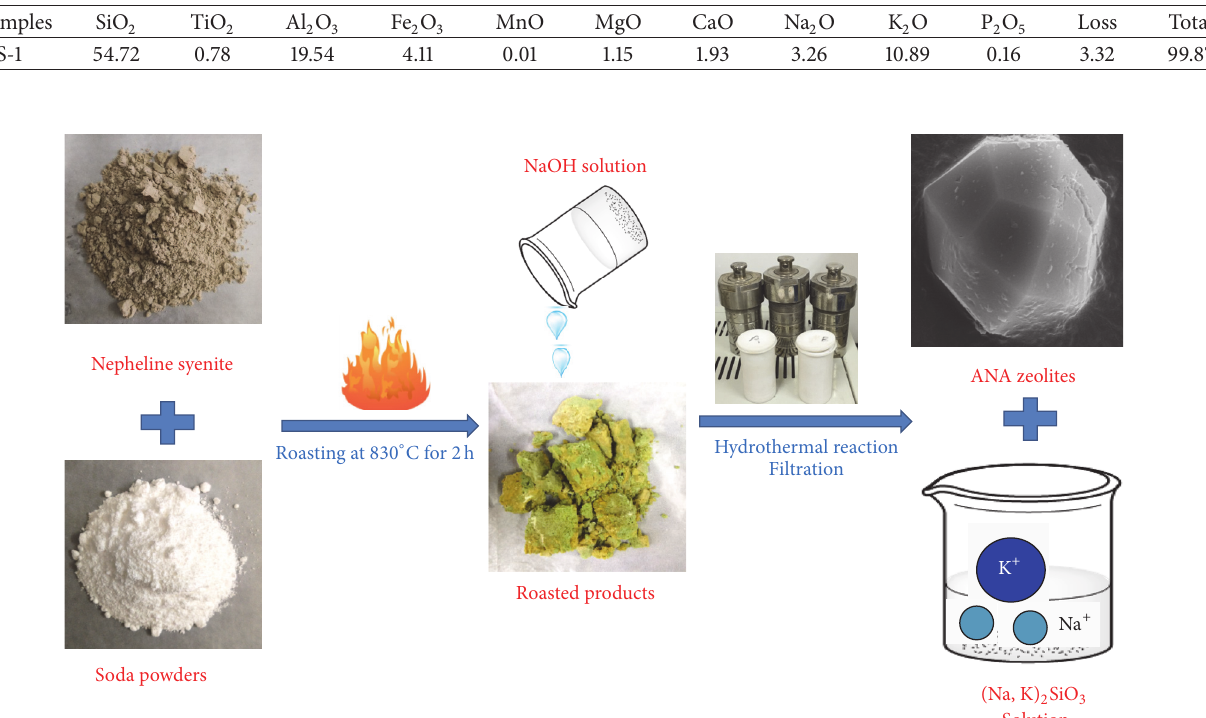
Figure 2: The schematic diagram of analcime synthesis with potassium extraction from natrolite syenite.